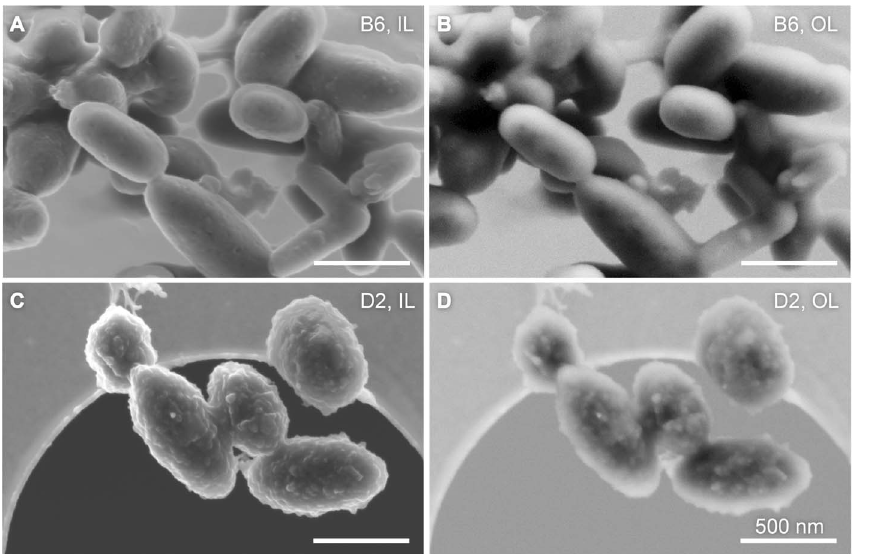
Figure 4. SEM images of freeze-dried C57BL/6J (B6) and DBA/2J (D2) melanosomes. The left column contains images recorded in the in- lens detector configuration (IL) and the right column shows micrographs acquired in the out-lens configuration (OL). A direct comparison shows that B6 melanosomes (A and B) have a rather smooth and featureless surface, whereas the D2 organelles (C and D) have an irregular surface. The samples were subjected to the identical preparation protocol. All scale bars represent 500 nm.